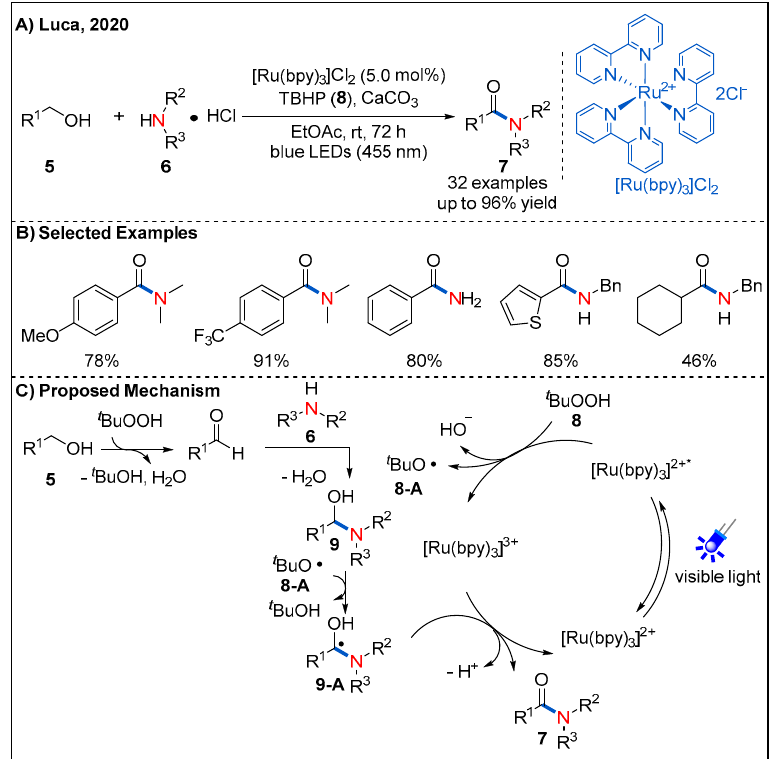
Figure 5. Oxidative amidation of x’alcohols.